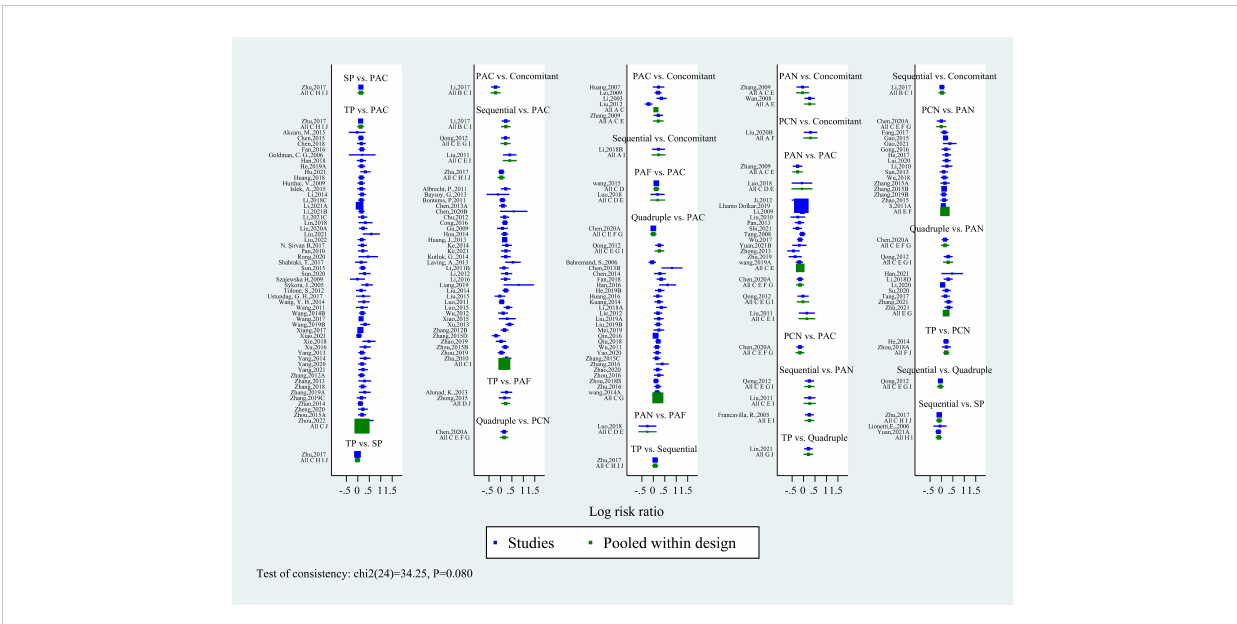
FIGURE 4 Forest plot of inconsistency test for 10 eradication regimens. The results show that the inconsistency is not signi fi cant (P>0.05). Regimen labels: B, bismuth-containing triple therapy; Concomitant, concomitant therapy; PAC, PPI, amoxicillin and clindamycin; PAF, PPI, amoxicillin and furanes; PAN, PPI, amoxicillin and nitroimidazoles; PCN, PPI, clindamycin and nitroimidazoles; Quadruple, quadruple therapy; Sequential, sequential therapy; SP, sequential therapy with probiotics; TP, triple therapy with